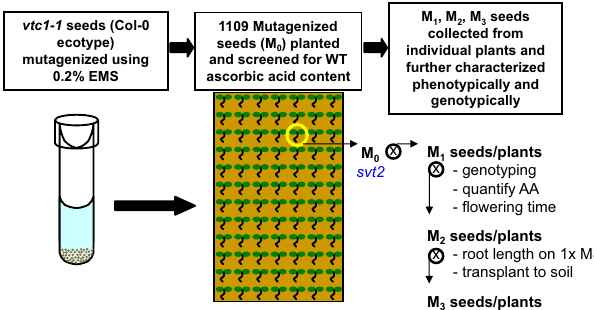
Figure 1. Isolation of svt2 . To isolate vtc1-1 suppressor mutants, homozygous vtc1-1 seed (in the Col-0 genetic background) were exposed to chemical mutagenesis using ethyl methanesulfonate (EMS). Over 1000 mutagenized seed (M ) were planted on soil and 0 screened for wild-type levels of ascorbic acid. The only mutant isolated in the M generation containing recovered ascorbic acid levels was 0 svt2 . The mutant was allowed to self-fertilize and was characterized phenotypically and genotypically in subsequent generations.